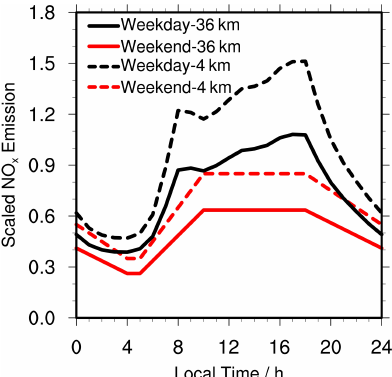
Figure 3. Relative diurnal profiles of weekday and weekend NO x emissions (moleculeskm − 2 s − 1 ) in the DISCOVER-AQ 2011 re- gion (the 36 and 4km grid cells over the 11 inland Pandora sites shown in Fig. 1) for the 36 and 4km REAM. All the pro- files are scaled by the 4km weekday emission average value (moleculeskm − 2 s − 1